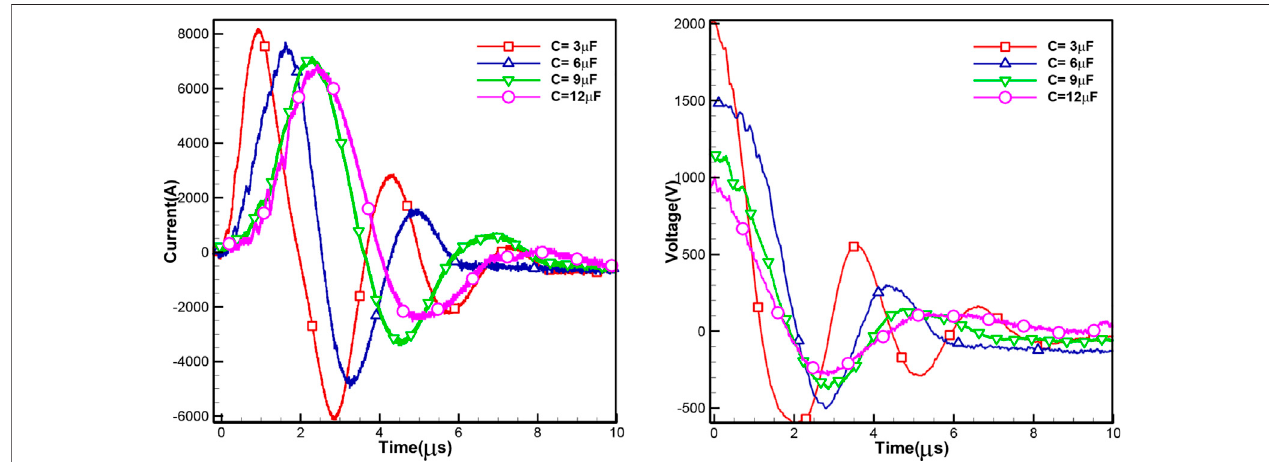
FIGURE 9 | Discharge waveforms of APPT under different capacitance and voltage con fi gurations ( E 0 (cid:2) 6J).